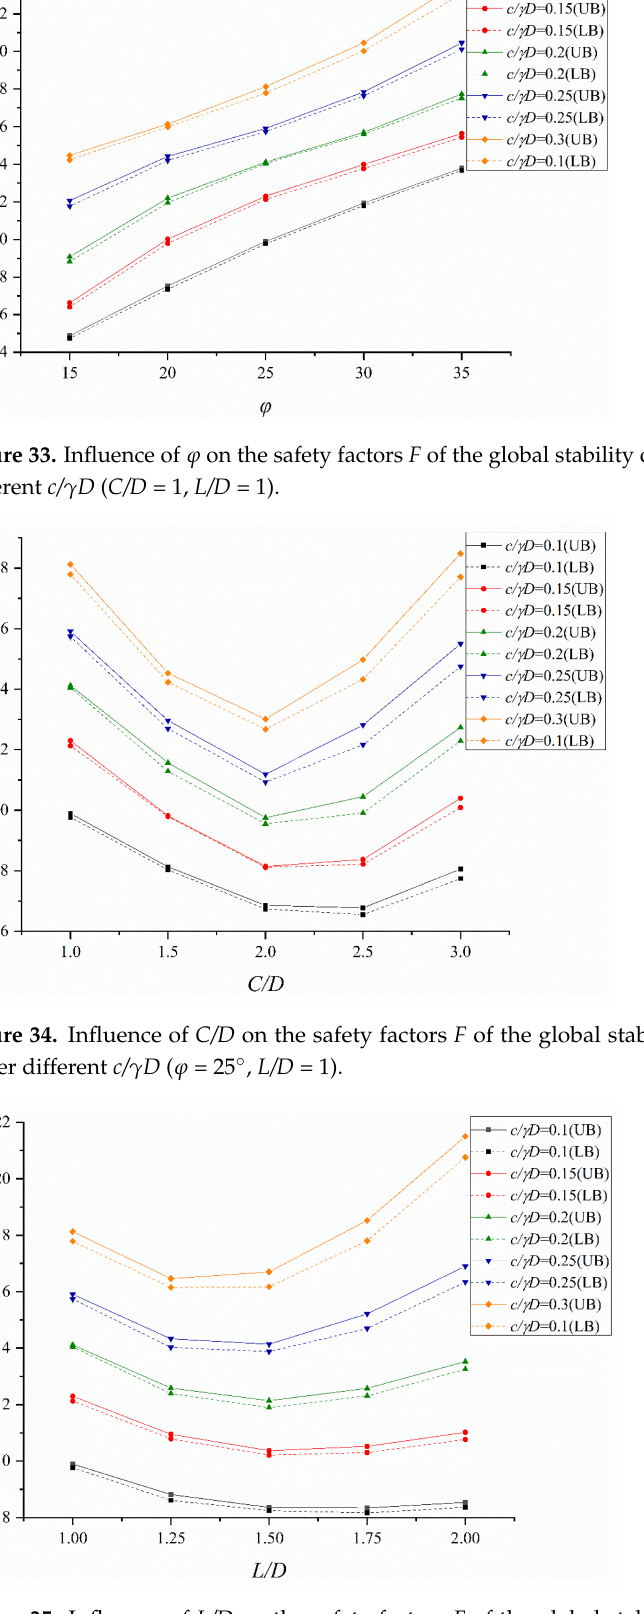
Figure 35. Influence of L/D on the safety factors F of the global stability of adjacent construction under different c/ γ D ( ϕ = 25 ◦ , L/D =